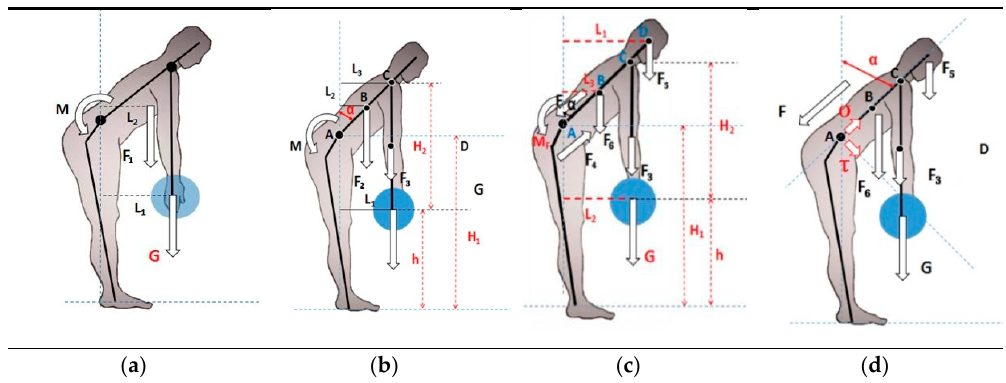
Figure 1. The Simplified L5-S1 Force Model. ( a ) The relationship model between Erector Spinae tension and object gravity; ( b ) The relationship model between Erector Spinae tension and the height of objects from the ground; ( c ) Static balance model when bending over; ( d ) Force analysis of L5/S1 in handling.